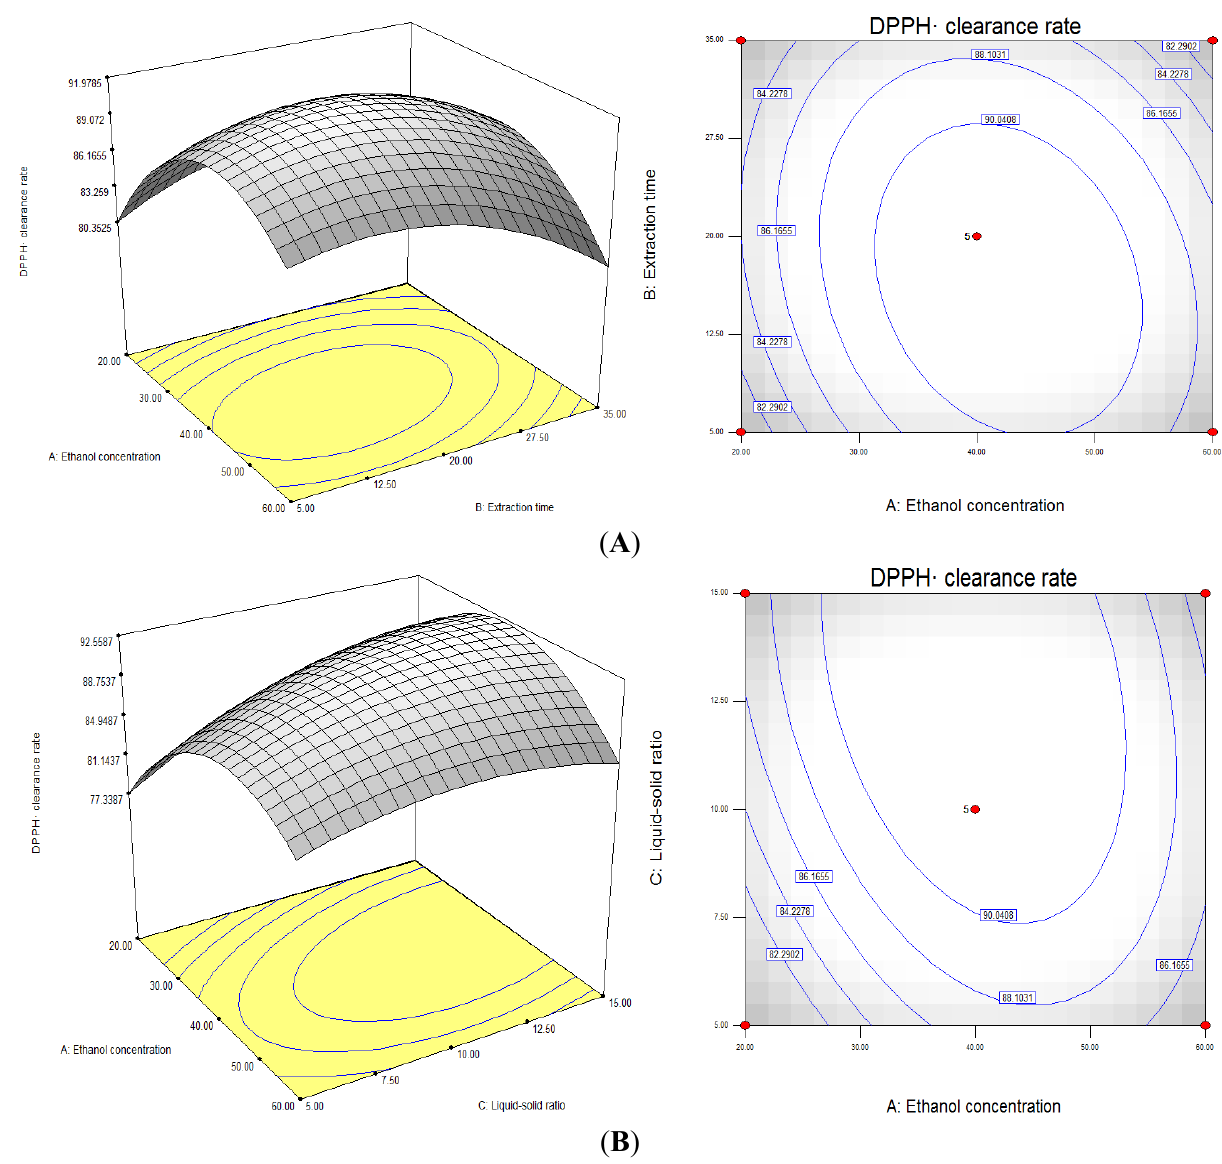
effects of extraction time and liquid-solid ratio on DPPH· scavenging rate Y = (B,